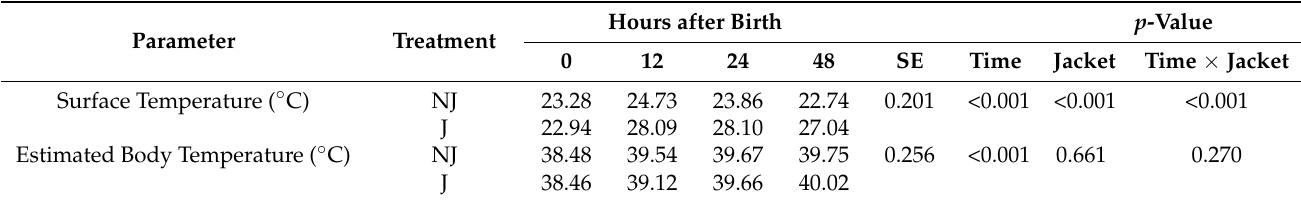
Table 2. Mean surface temperature (°C) and estimated body temperature (°C) of non-jacketed (NJ) and jacketed (J) lambs for the first 48 h of life.